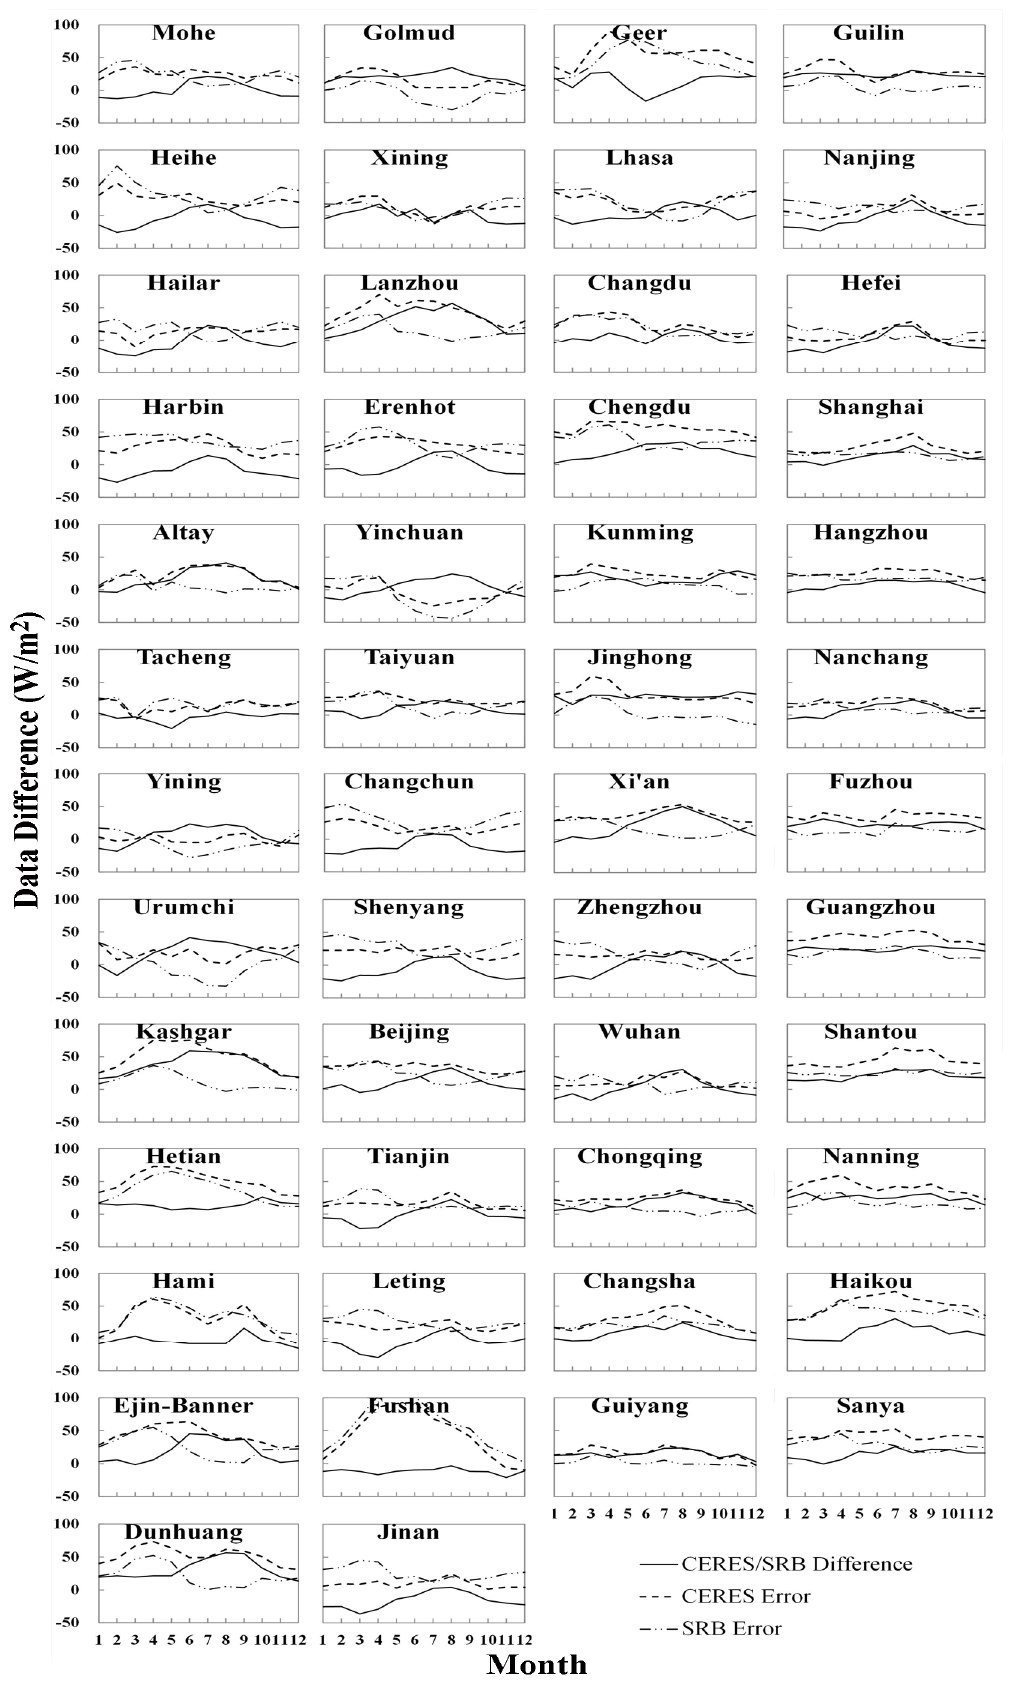
Figure 6. Monthly variation of errors in surface net radiation generated from the CERES and the SRB